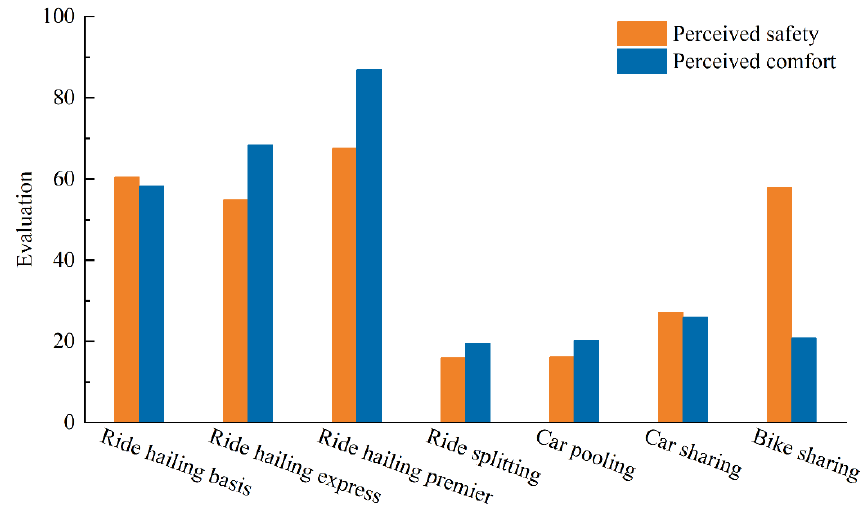
Figure 3. The perceived safety and comfort of different shared mobility services.